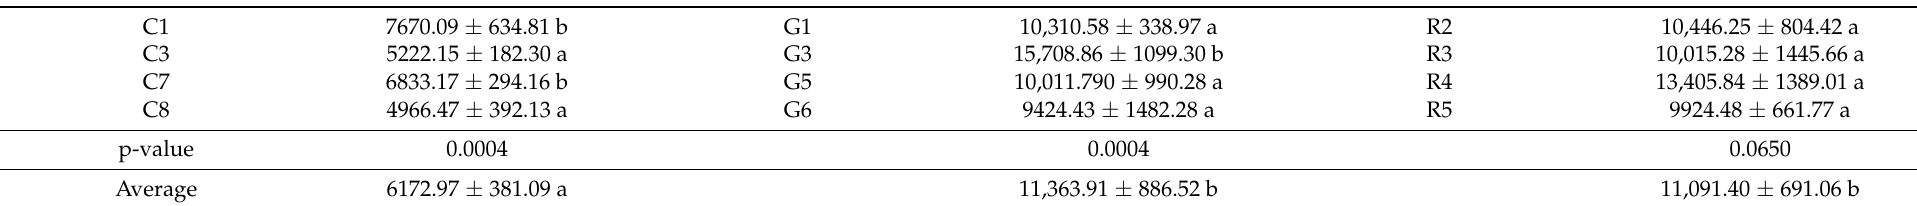
Table 4. Global analysis using all nutrients (ppm) at the cultivar and genotype level. Data are means ± SEM of 9 replicates with different letters for each column (genotypes) or rows (cultivars) indicating significant differences ( p -value < 0.01) as determined by LSD multiple comparisons test.